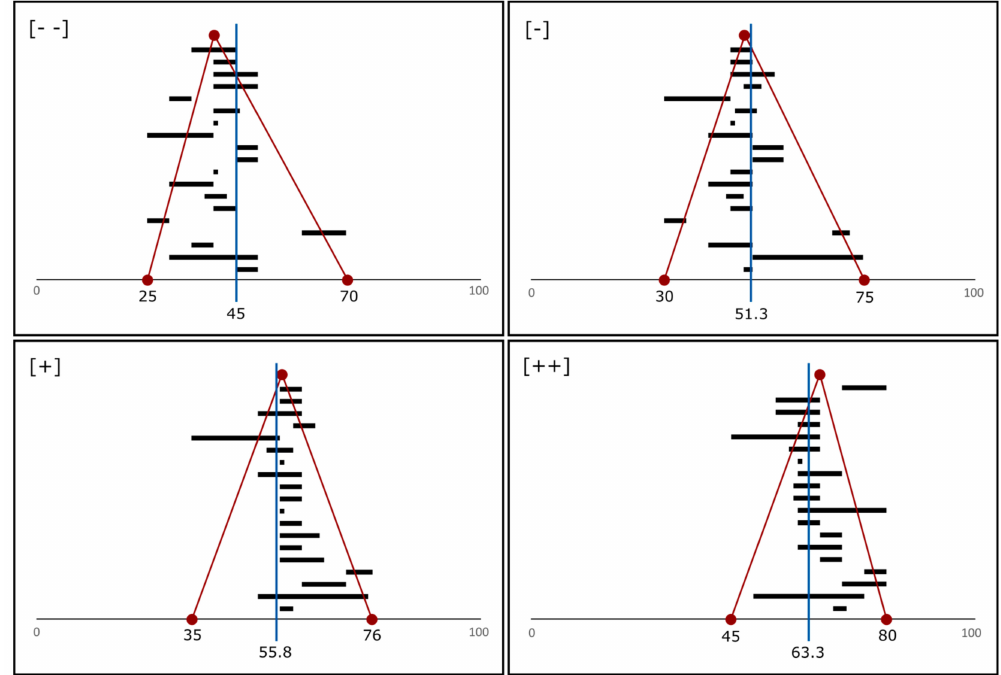
Figure 3. Center of gravity (blue line) for each trend category ([- -] = large decrease; [-] = decrease; [+] = increase; [++] = large increase), computed as the average of the minimum, maximum, and median values (in red) of the experts’ quantitative ranges (in black).